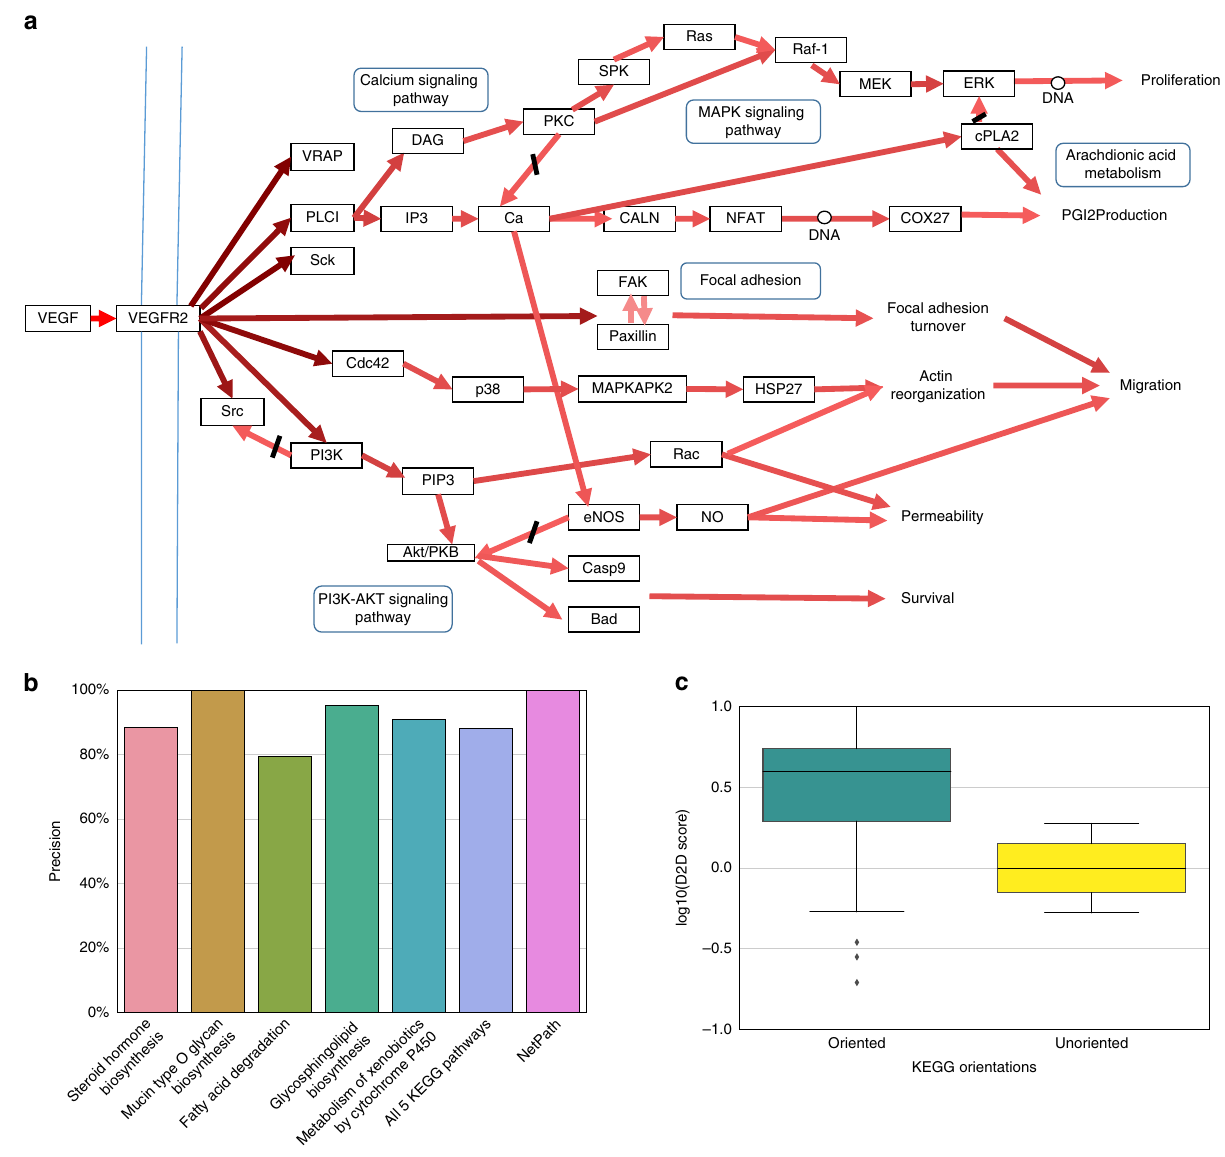
Fig. 2 Small-scale examples of D2D on KEGG pathways. a The VEGF signaling pathway from KEGG is oriented based on D2D scores from a single experiment, connecting input nodes (VEGF) to output nodes (VRAP, Sck, Proliferation, PGI2Production, Migration, Permeability and Survival). The fi gure depicts the directions chosen for each of the interactions, where the color of an interaction represents the con fi dence in its orientation, the direction of an arrow indicates the inferred interaction direction, and a black mark indicates a direction inference which is inconsistent with the KEGG annotation. 92% of the interactions are oriented as cataloged in KEGG. b Similar high concordance between the predicted and true orientations in KEGG is obtained when analyzing the fi ve largest pathways in KEGG and the NetPath resource. c Show-case of D2D score distribution in the Steroid hormone biosynthesis pathway from KEGG, separated to the scores assigned to the oriented interactions in KEGG and the scores assigned to those interactions that are unoriented in KEGG. The box plots were plotted using seaborn python package with the default setting such that the center line stands for the mean of the distribution, the box extends from the fi rst to the third quartile of the distribution and the whiskers extend to 1.5